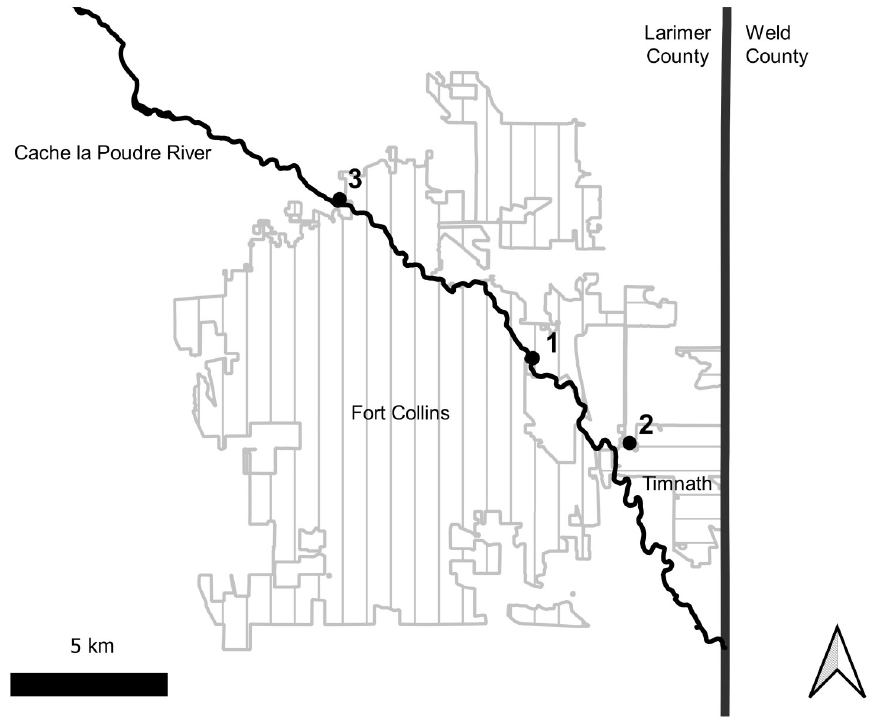
Fig 1. Map of sites for collection of wild mosquitoes in northern Colorado. Numbers indicate the experimental replicate associated with each site. City boundary data available at from Colorado Department of Public Health and Environment (https://data-cdphe.opendata.arcgis.com/datasets/colorado-county-boundaries/) and hydrology data from the United States Geological Survey National Hydrography Dataset https://apps.nationalmap.gov/downloader/.